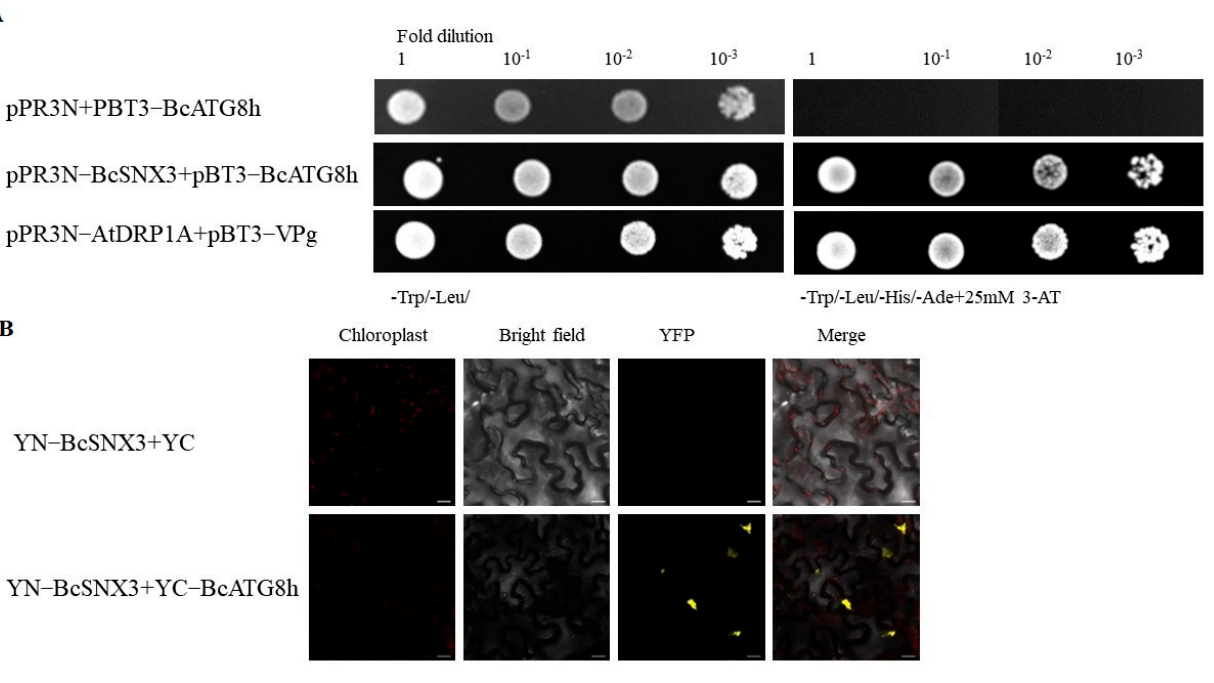
Figure 5. BcSNX3 interacts with BcATG8h. ( A ) Yeast-two hybrid (YTH) assays for possible interactions between BcSNX3 and BcATG8h. ( B ) BiFC assays between BcSNX3 and BcATG8h in the leaves of N. benthamiana . Confocal imaging was performed at 60 – 72 hpi. Bars, 20 μ m.